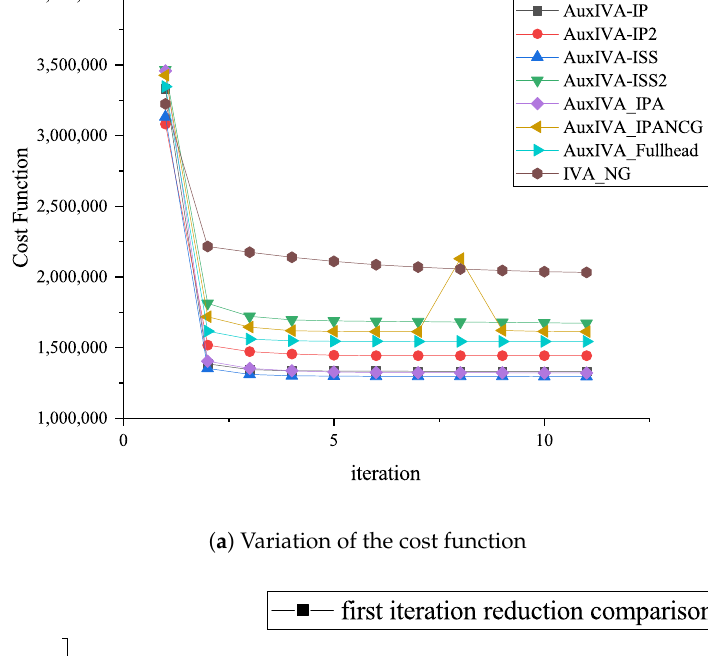
source separation in the environment. From the separation effect, it can be seen that